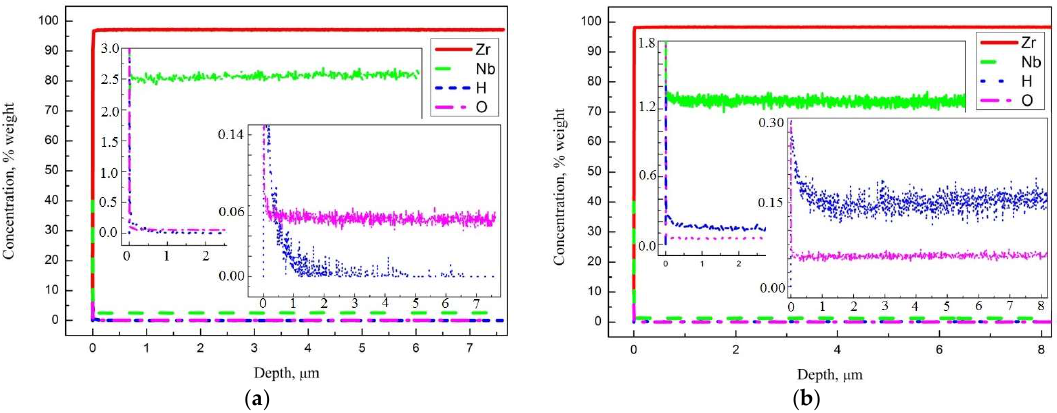
Figure 5. The depth profile of ( a ) Zr-2.5Nb alloy after annealing without hydrogenation and ( b ) Zr-1Nb alloy after annealing, hydrogenation, and maintenance in inert gas atmosphere.